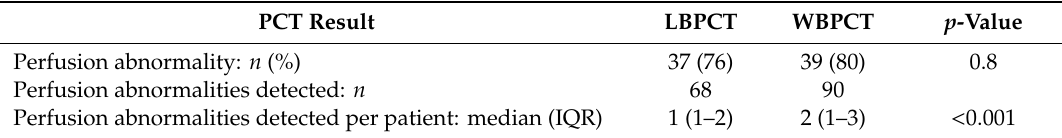
Table 2. Comparison of WBPCT versus LBPCT findings.